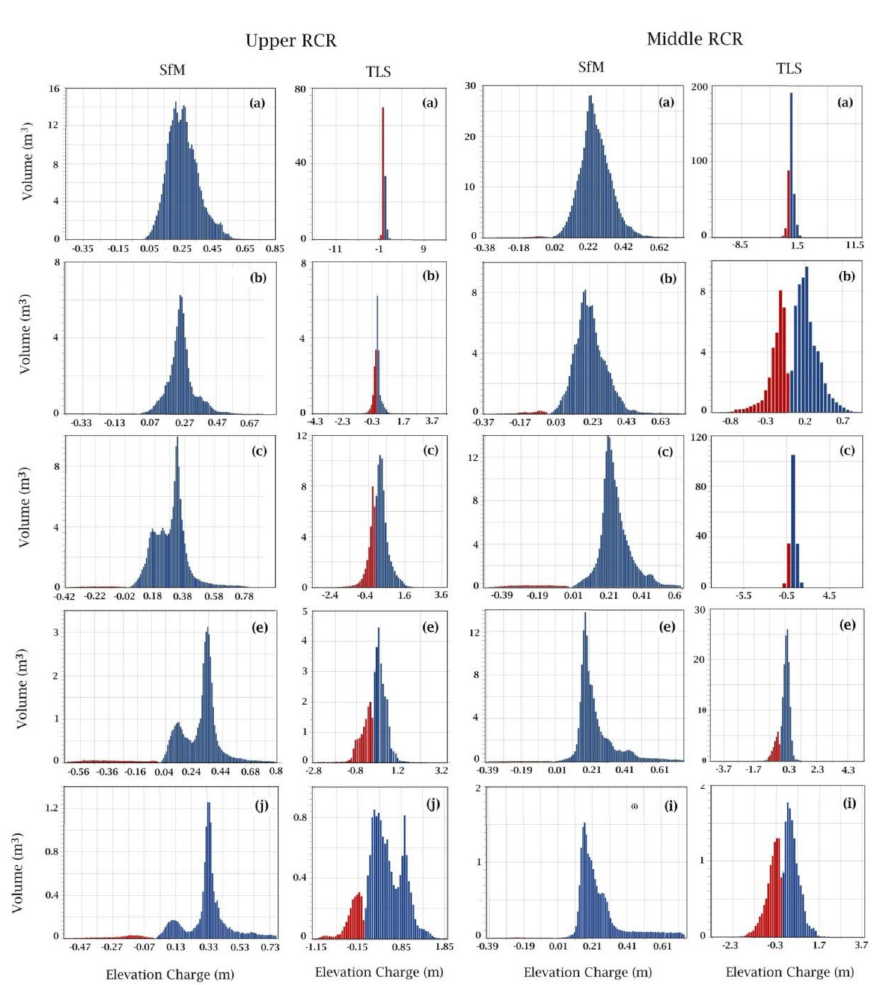
Figure 13. Di ff erences in absolute net volumes versus variations in elevation (lowering and raising) of the bed surface detected with SfM and TLS for each GRU in the Upper and Middle RCR, after the peak flow of 19–20 April 2019. Letters refer to the RGU according to the legend in Figure